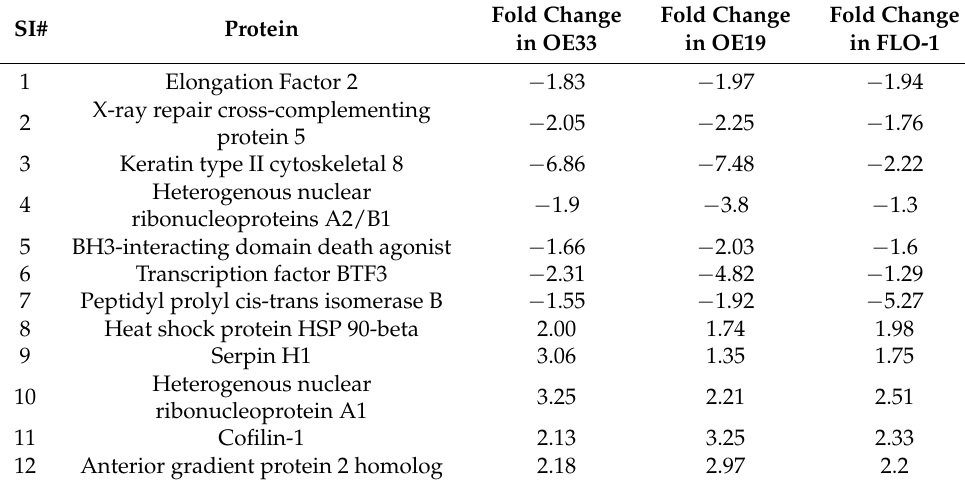
Table 1. Differentially Regulated Entities on Resveratrol Treatment in OE33, OE19 and